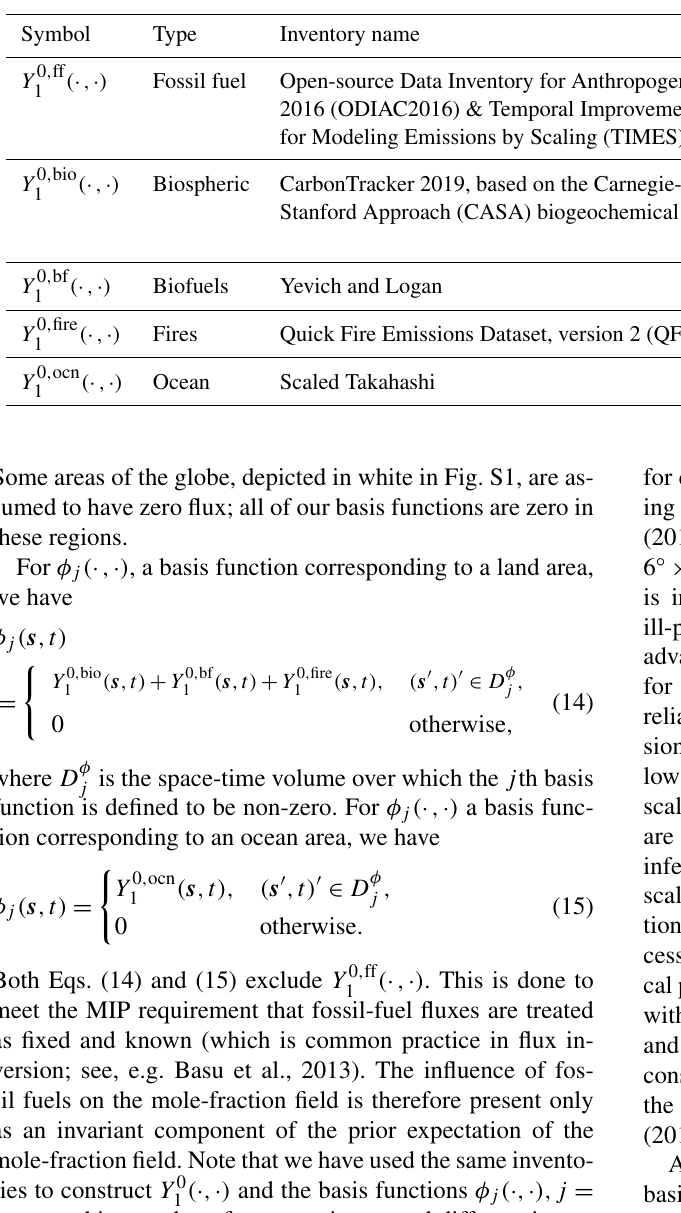
Table 1. Components of the flux prior Y 0